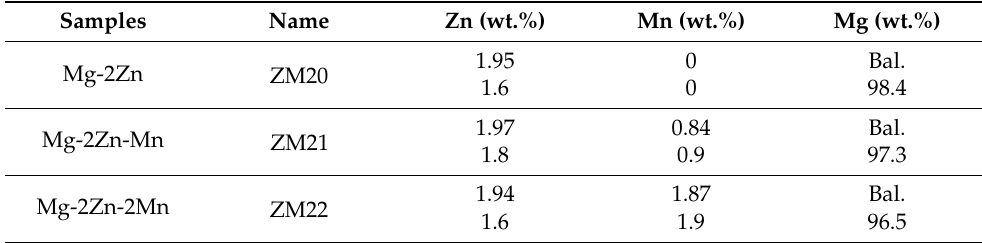
Table 1. The weight percentage (upper row) of metallic powders for preparation of Mg-2Zn- x Mn alloy and their real corresponding percentage (lower